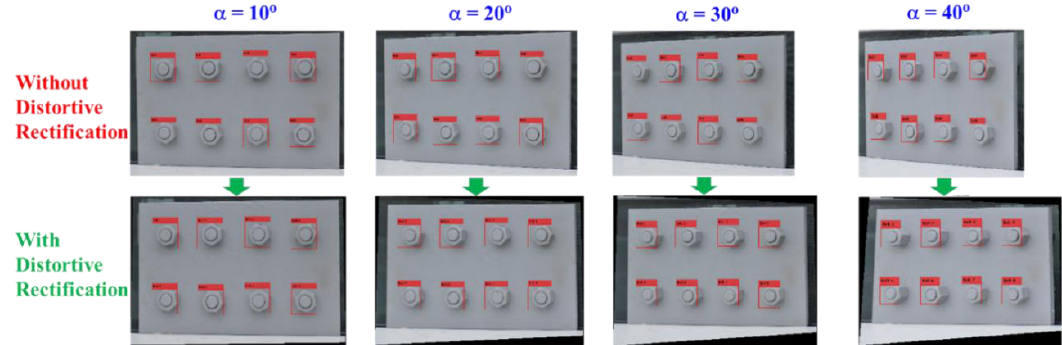
Figure 10. Detection of bolts in the distorted and undistorted images of the lab-scaled connection model.